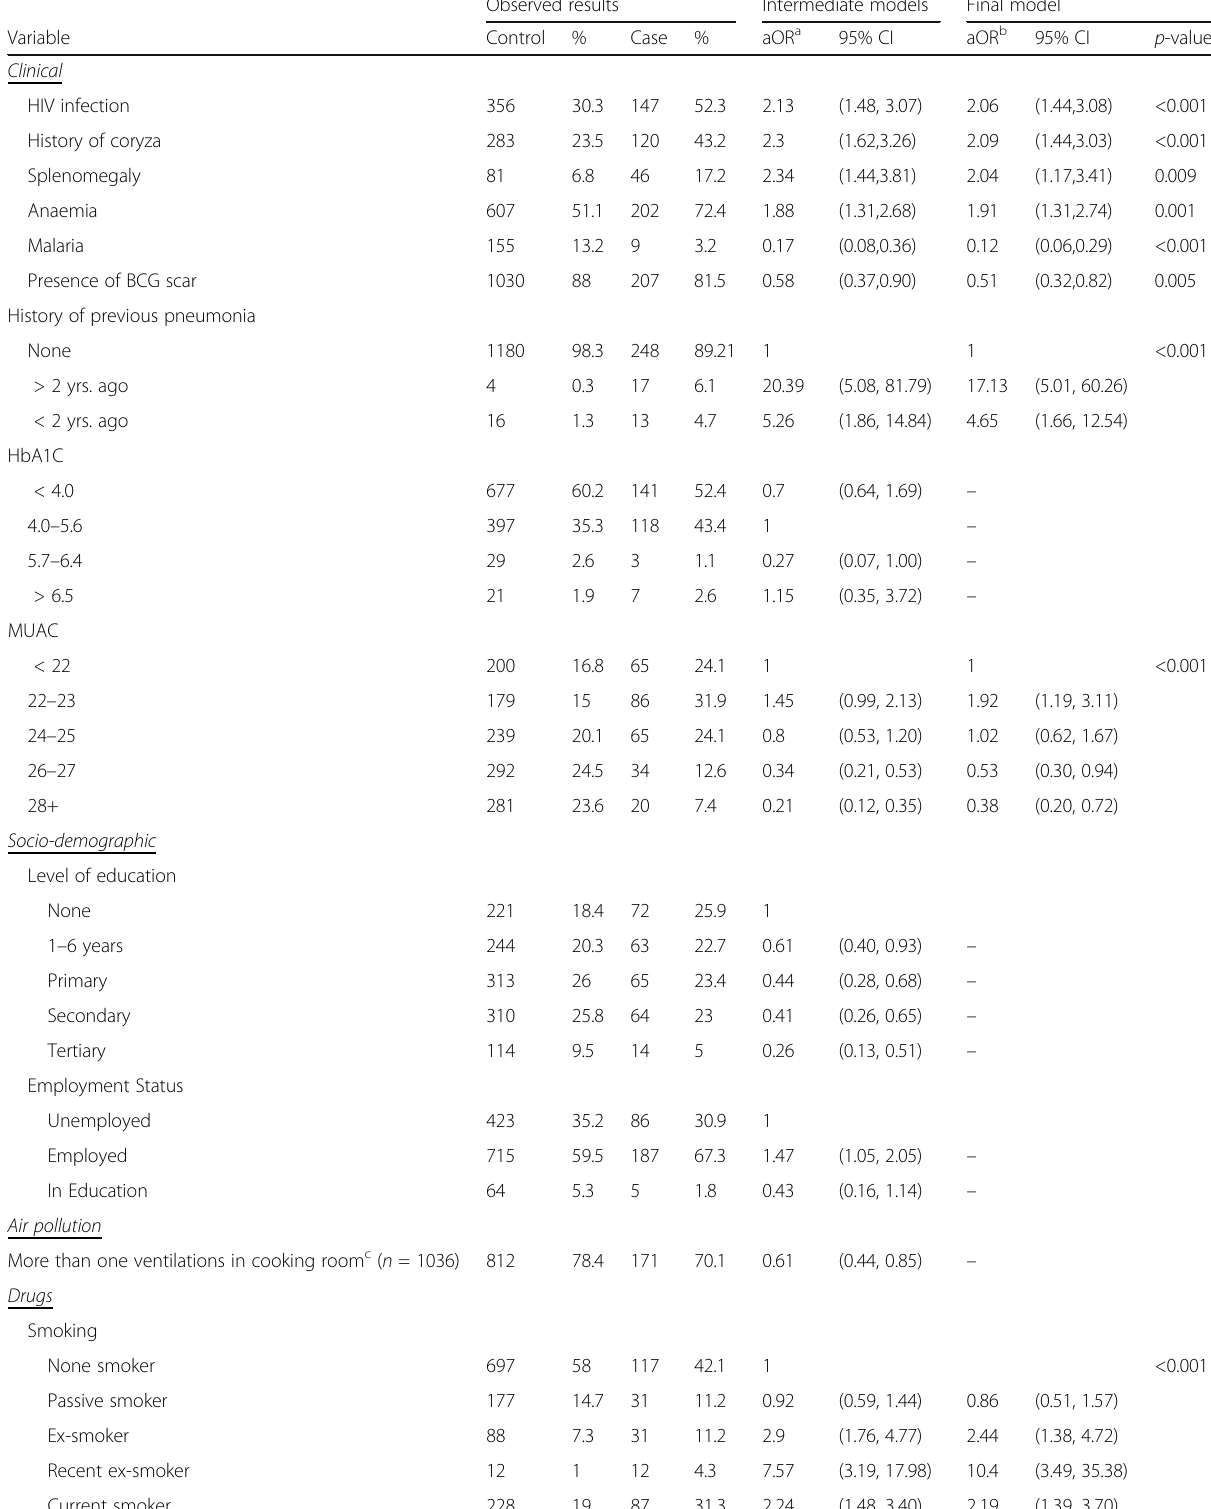
Table 3 Risk factors for pneumonia in intermediate and final regression